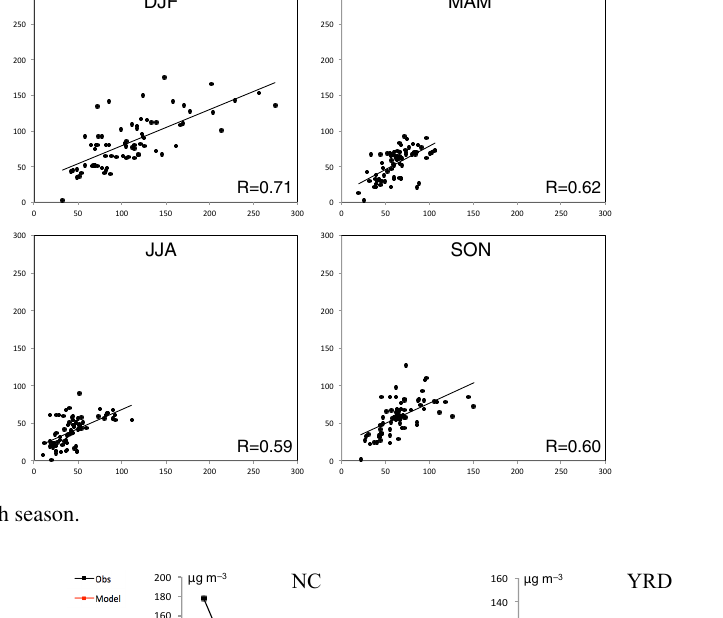
Figure 3. Correlation maps for each season.